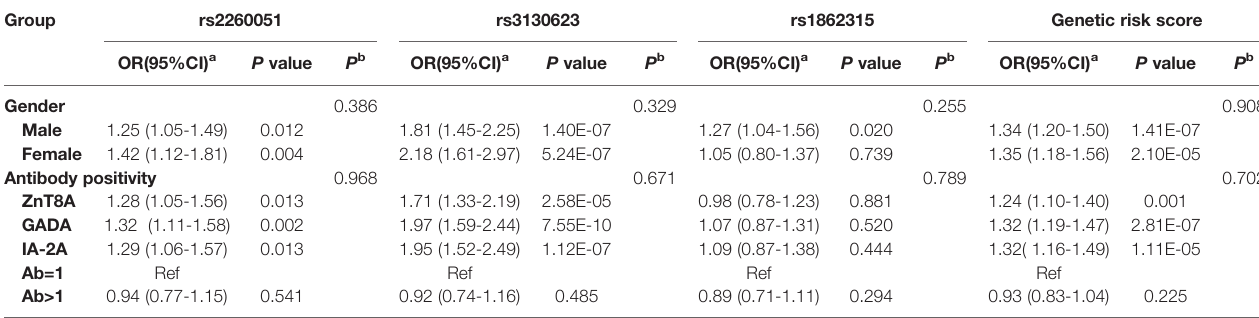
TABLE 3 | Associations of the m6A regulator SNPs with islet autoantibody positivity. Group